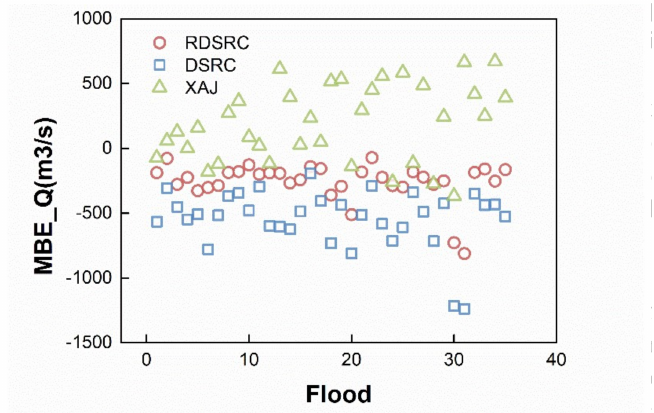
Figure 10. Plot depicting the performances of DSRC, RDSRC and XAJ as measured by the mean bias error ( MBE ).